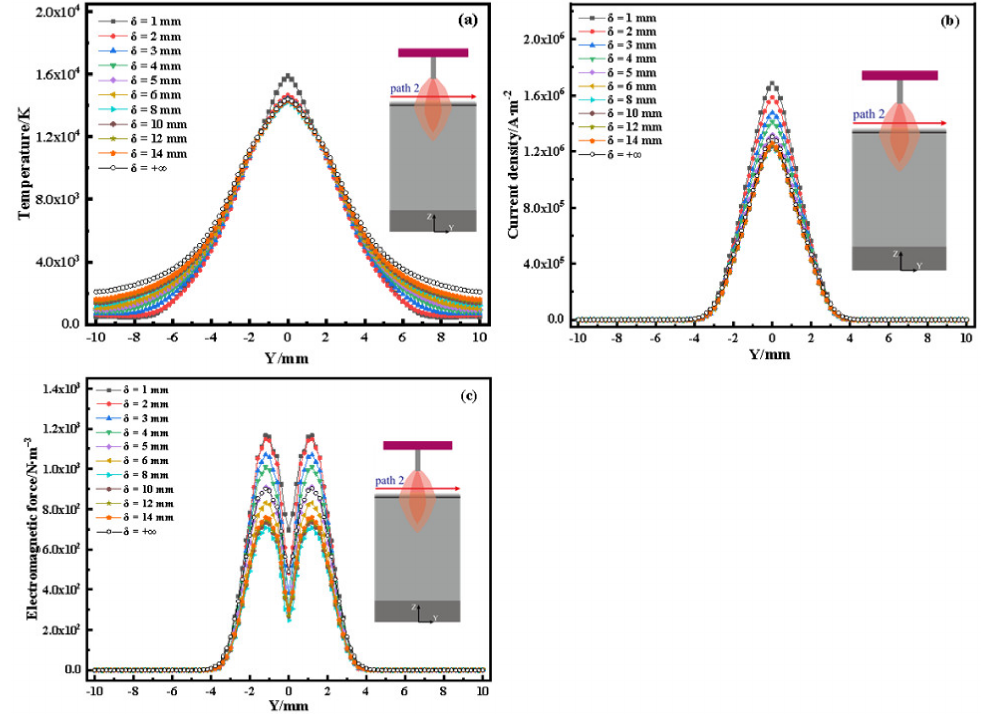
Figure 6. Distribution of main parameters on path 2: ( a ) temperature; ( b ) current density; ( c ) electromagnetic